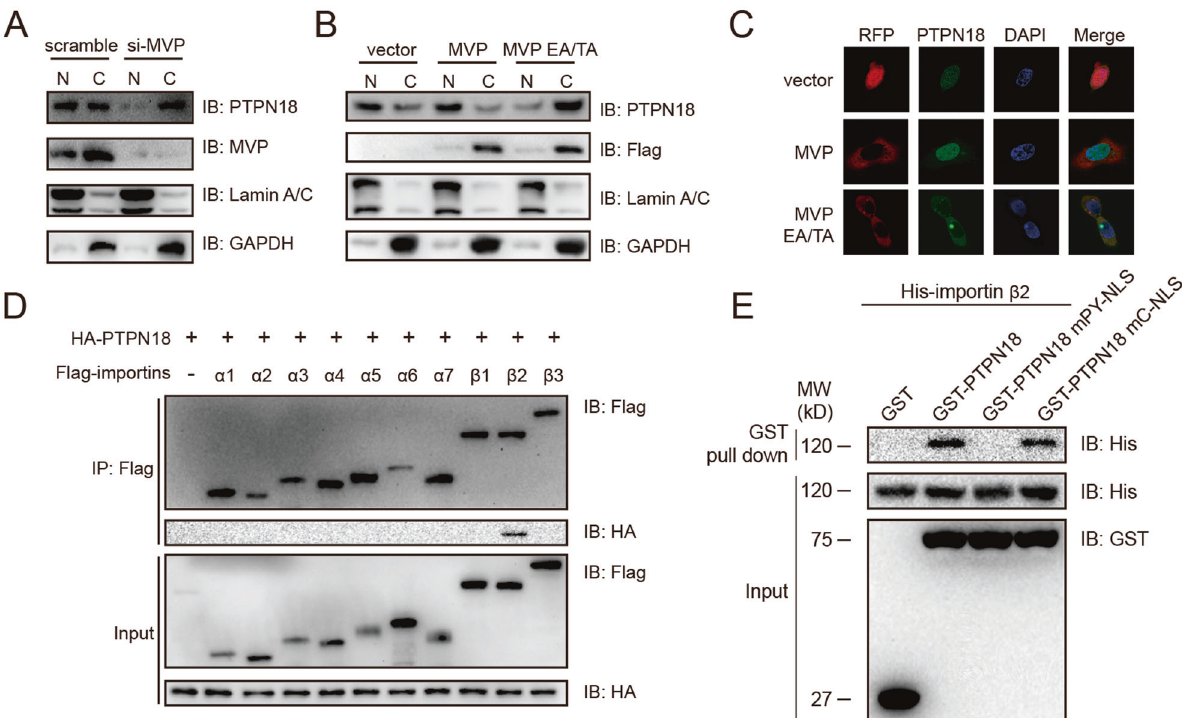
Fig. 3 MVP and importin β 2 cooperate to facilitate PTPN18 nuclear localization. A Immunoblot of the PTPN18 nucleocytoplasmic distribution after transient knockdown of MVP. N nucleus; C cytoplasm. B Immunoblot of the PTPN18 nucleocytoplasmic distribution after ectopic expression of MVP and its mutants. N nucleus; C cytoplasm. C Immuno fl uorescence analysis of the PTPN18 nucleocytoplasmic distribution in MCF7 cells after ectopic expression of MVP and its mutants. D Interactions between PTPN18 and importin family were examined by Co-IP. E GST pull-down assay of GST-tagged PTPN18 and its NLS mutants with His-tagged importin β